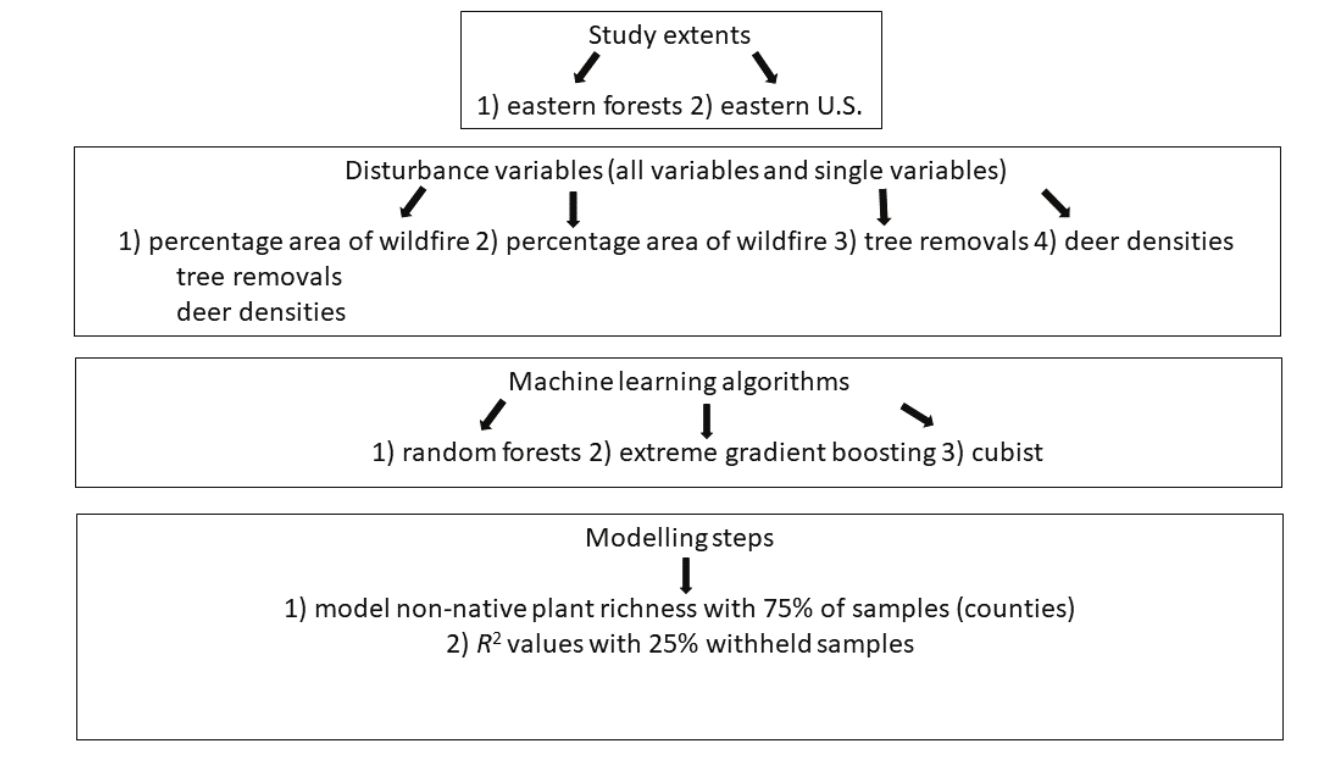
Figure 2. Flow chart of methods